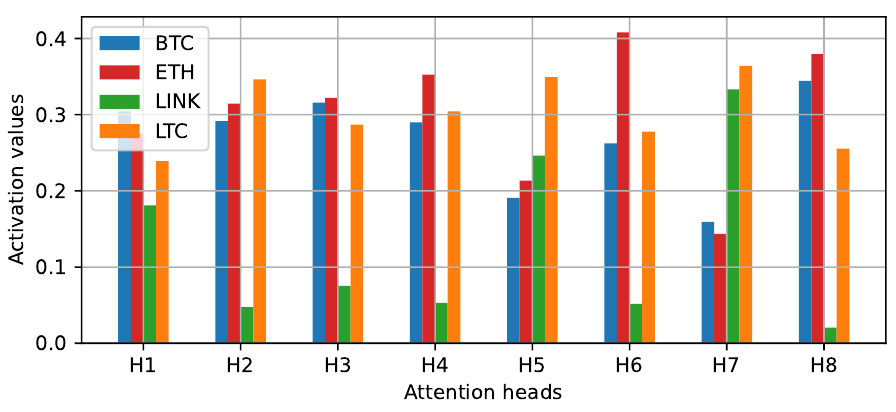
Figure 9. Attention values of a self-attention